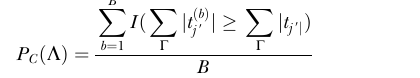
Figure S3. Statistically Significant Type II Neighbor Clusters in the SF370 Genome Figure S4. Statistically Significant Type III Neighbor Clusters in the SF370 Genome Table S1. Summary of All Streptococcal Genes Exhibiting Differential Expression during Adherence to Pharyngeal Cells as Compared with Associated Streptococcal Control Table S2. DNA Primers Used in This Study Table S3. Fold Changes in Gene Expression Estimated Using Microarray and Real-Time Quantitative PCR Table S4. All Putative Neighbor Clusters Generated by Genome- Crawler Table S5. Putative Neighbor Clusters Following Visual Inspection Table S6. Summary of Neighbor Clusters Identified as Putative Operons through In Silico Inspection Table S7. Comparison of Log-Fold Changes of Genes Reported in a Previously Published Microarray Study of S. pyogenes SF370 Table S8. Summary of All Genes in a Mga-Deficient SF370 Mutant Exhibiting Differential Expression during Growth in Culture Broth Compared with the Parental SF370 Control Table S9. Putative Neighbor Clusters Identified by GenomeCrawler in Published Microarray Dataset from S. pyogenes